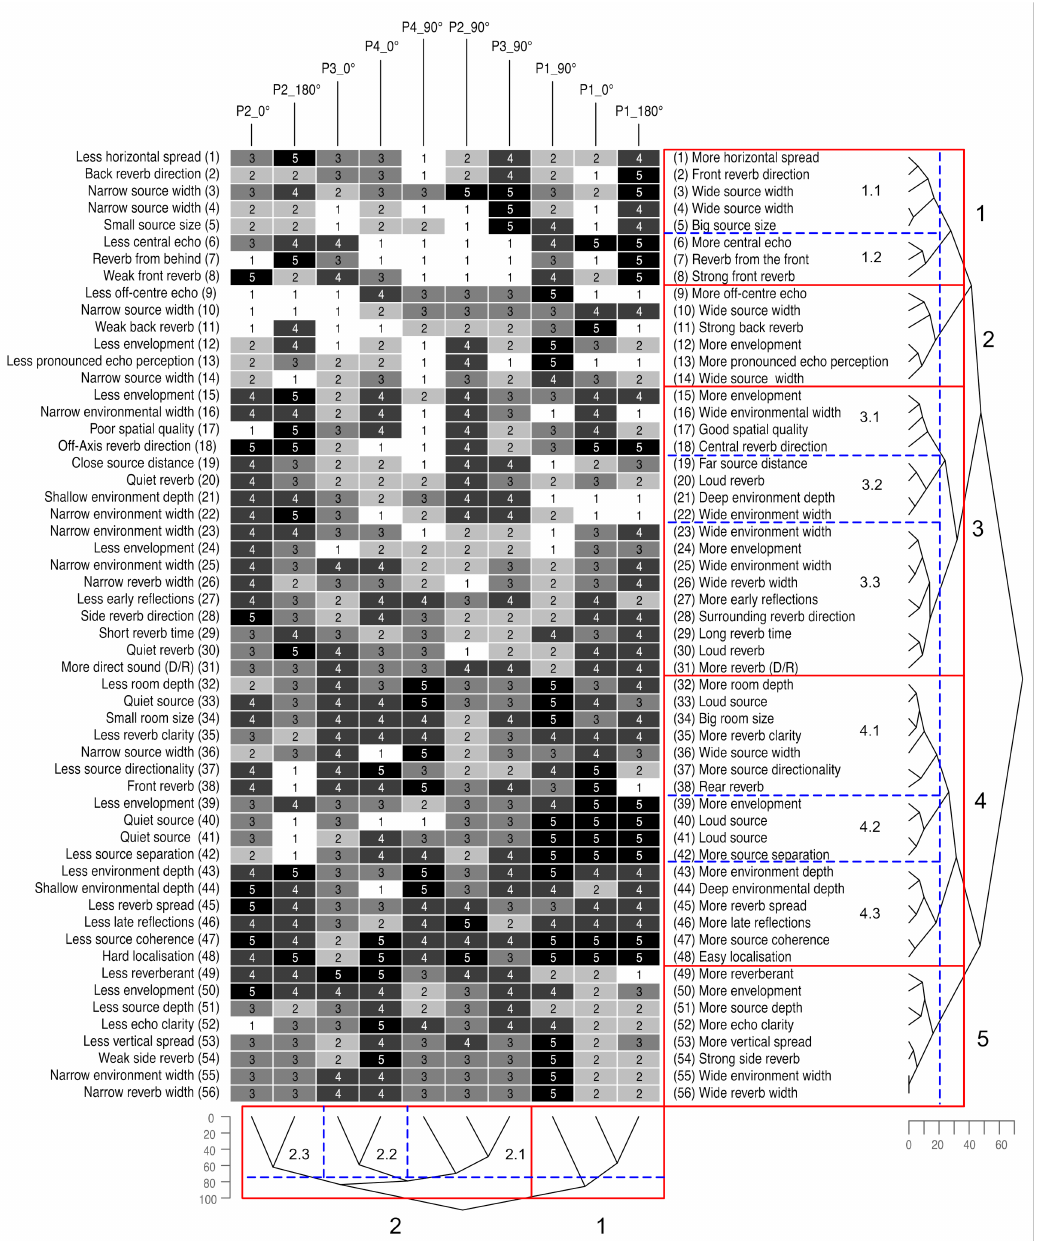
Figure A1. Elicited terms along with the RGT ratings from the in-situ